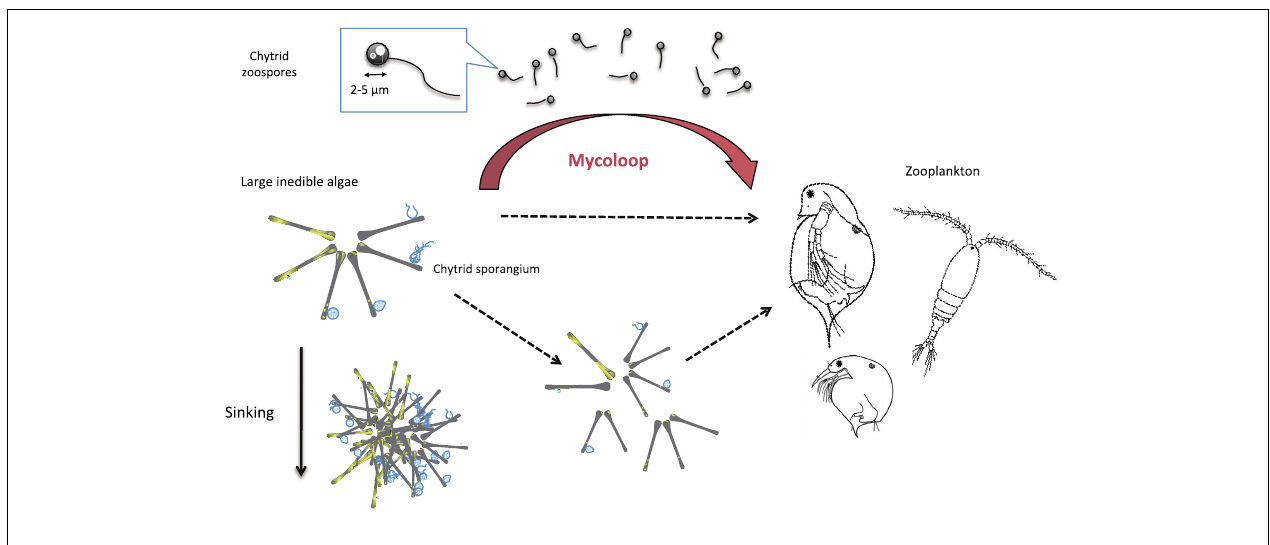
FIGURE 1 | Diagram of “mycoloop.” Parasitic chytrids can transfer material from large inedible phytoplankton to zooplankton. Chytrids zoospores are excellent food for zooplankton in terms of size (2–5 μ m in diameter), shape, nutritional quality (rich in PUFAs and cholesterols). Large colonies of host